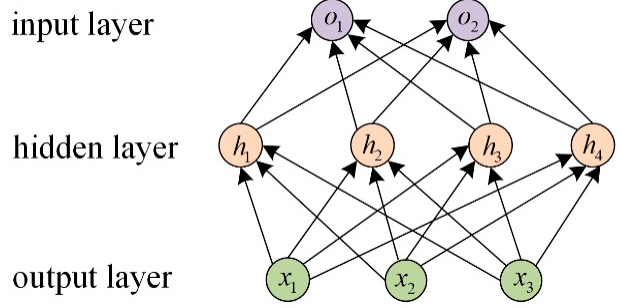
Figure 1. Multilayer perceptron with hidden